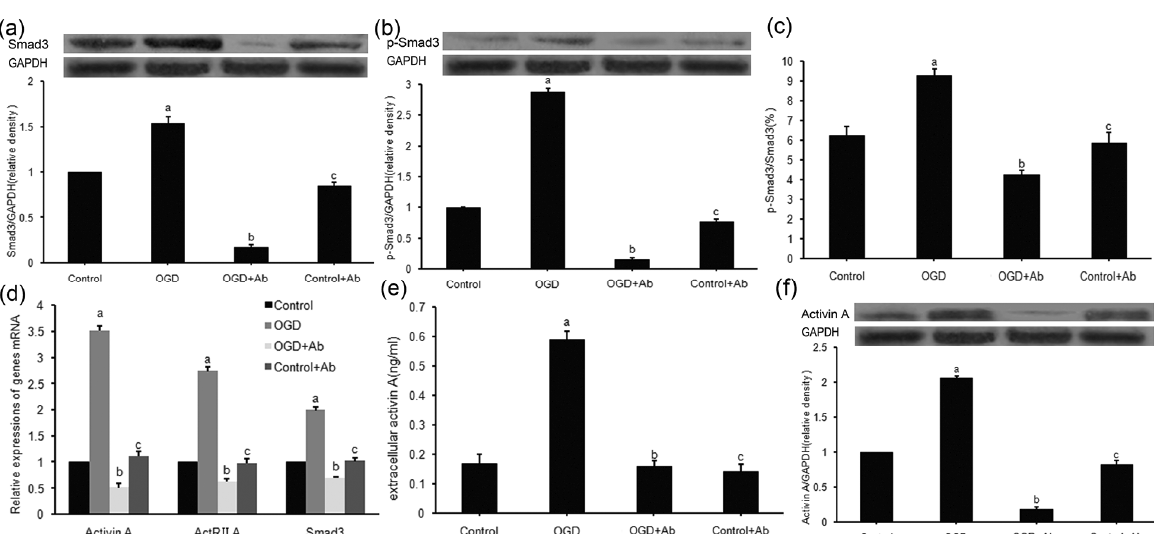
Figure 2. Effects of ActRII-Ab on ActA transmembrance signaling and extracellular secretion. ( a , b ) Smad3 ( a ) and p-Smad3 ( b ) protein was up-regulated (53.9 ± 7.1% and 187.4 ± 6.8% respectively) by 3 h OGD, but was inhibited (88.9 ± 3.4% and 94.9 ± 4.5% respectively) by ActRII-Ab. ( c ) 3 h OGD stimulated a 48.9 ± 7.2% increase in phosphorylation level of Smad3, but was inhibited 54.4 ± 4.2% by ActRII-Ab. ( d ) ActA, ActRIIA and Smad3 genes were up-regulated due to 3 h OGD (251.6 ± 9.7%,174.2 ± 6.2% and 99.6 ± 7.0%, respectively), but inhibited (85.4 ± 8.2%,77.2 ± 6.3% and 64.9 ± 2.2% respectively) by ActRII-Ab. ( e , f ) The ActRII-Ab decreased the extracellular secretion of ActA protein by 73.2 ± 2.1% ( e ) and intracellular expression by 91.3 ± 3.7% ( f ). (a: compared to control group, p < 0.05; b: compared to OGD group, p < 0.05; c: compared to control group, p >